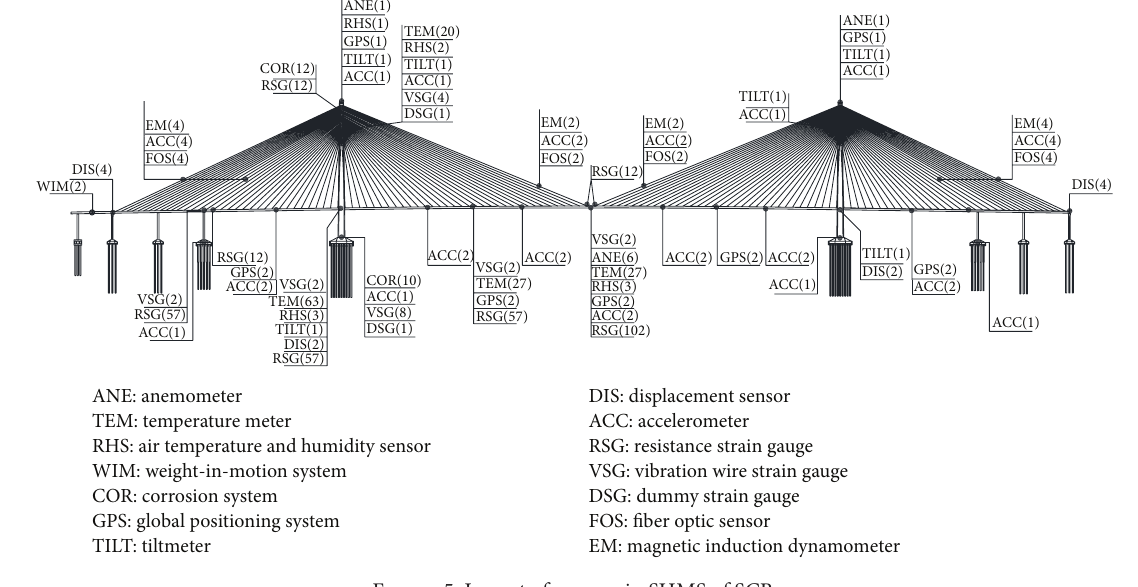
Figure 5: Layout of sensors in SHMS of SCB.